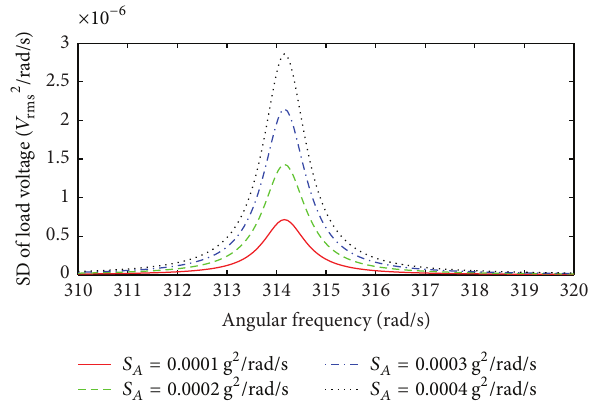
Figure 11: SD of the load voltage as a function of angular frequency for low levels of broad band Gaussian white random excitation; spring scaling factor 𝜂 = 5 m −2 and damping scaling factor 𝛼 = 0.05 s 2 m −2